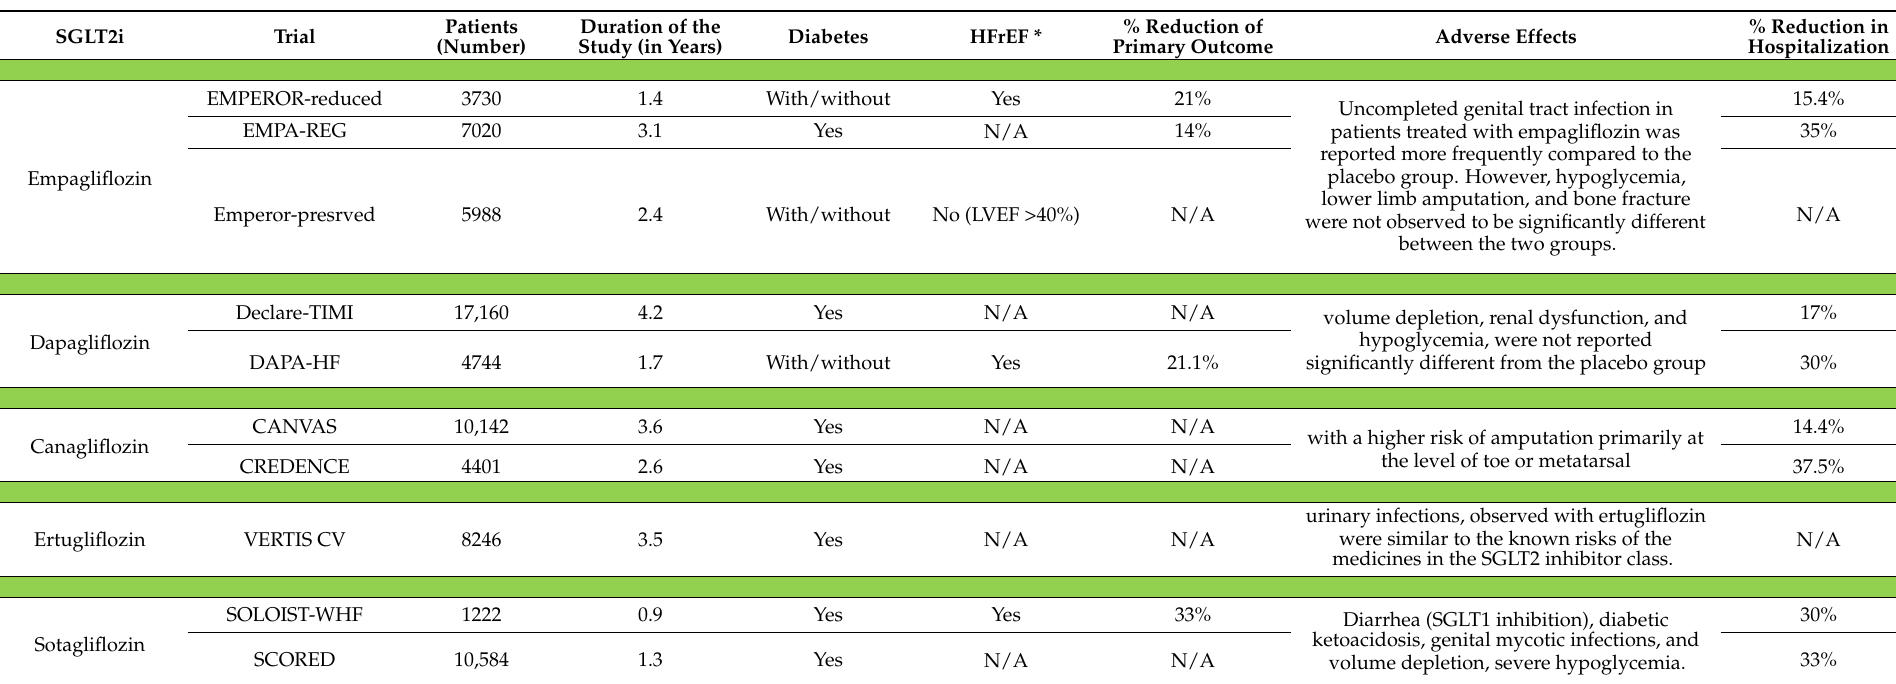
Table 2. Clinical Trials and effects of the SGLT2i: summary of the clinical trials of SGLT2i, most significant adverse effects, % reduction of hospitalization and primary outcome (* HFrEF: Heart Failure reduced Ejection